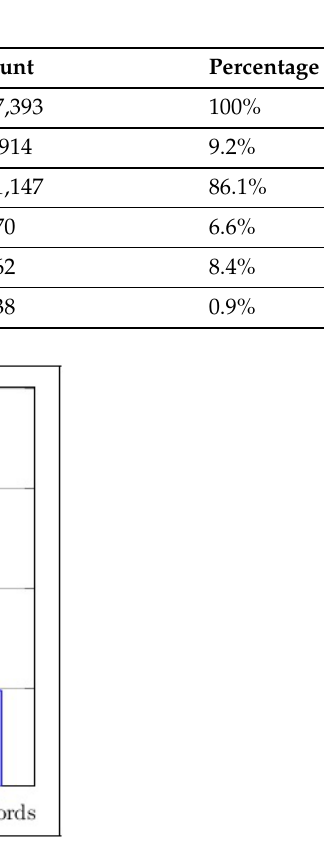
Figure 1. Transliteration words ratio to Urdu words in sample